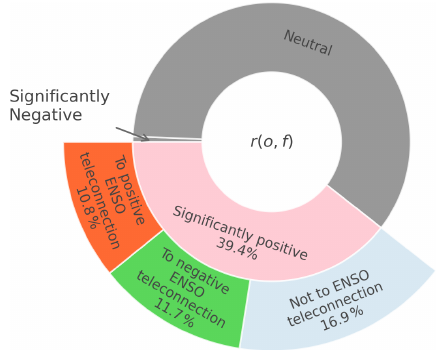
Figure 7. Sunburst diagram of the attribution of significantly pos- itive anomaly correlation to ENSO teleconnection for CFSv2 fore- casts in